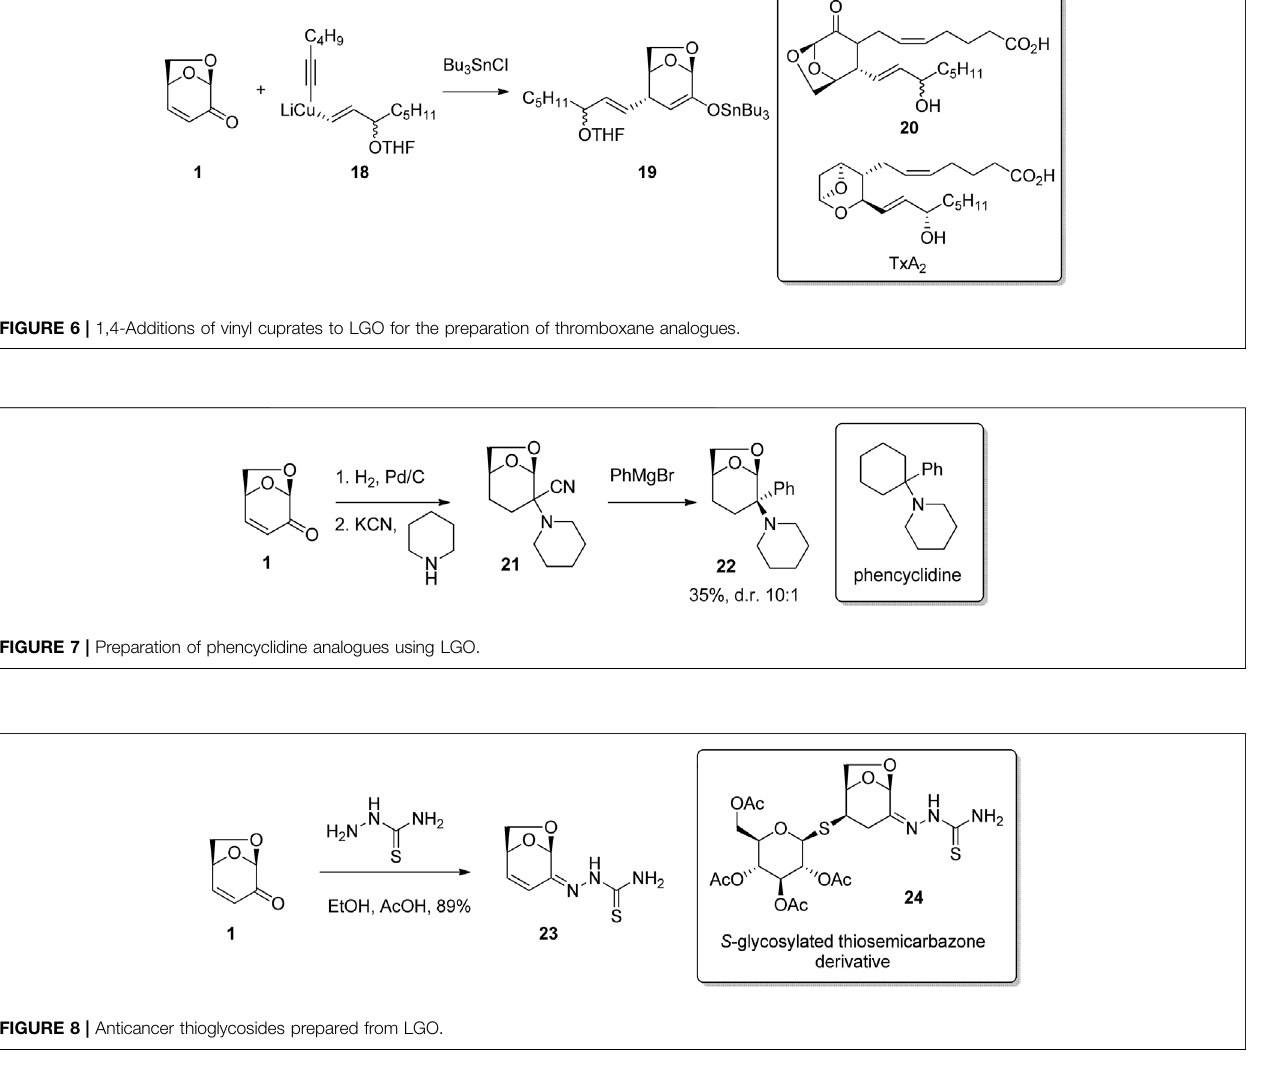
FIGURE 8 | Anticancer thioglycosides prepared from LGO.